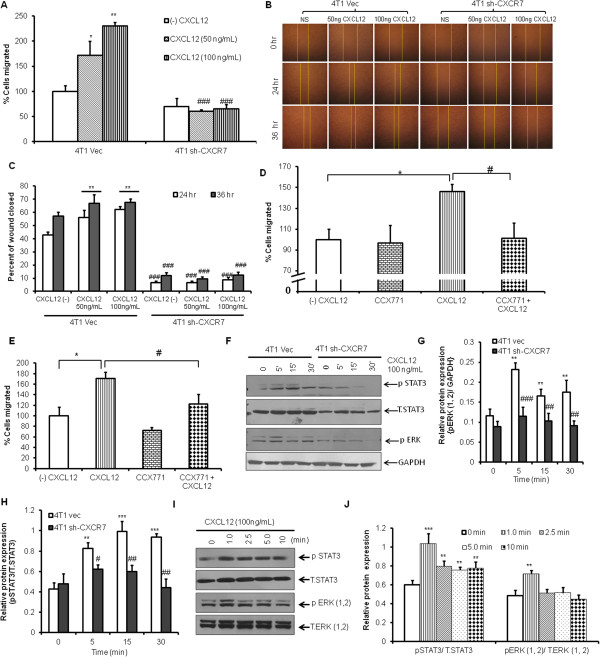
CXCL12 enhances CXCR7-mediated cell migration and signaling. (A) 4T1 Vec and CXCR7 shRNA-transfected cells were subjected to chemotaxis toward CXCL12 (50 and 100 ng/ml) by using the modified Boyden chamber assay, as described in Materials and methods. (B) 4T1 Vec and CXCR7 shRNA-transfected cells were grown to confluence in complete medium in six-well plates, and then a wound was made with a 200-μl pipette tip, and the closure of the wounds was monitored in the presence or absence of CXCL12 (50 and 100 ng/ml) by microscopy after 24 and 36 hours. (C) Quantitative analysis of percentage of wound closure. (D) 4T1 and (E) 4T1.2 cells were pretreated for 1 hour with vehicle or CCX771 (1 μM) and were subjected to chemotactic assay in the absence or presence of CXCL12 (100 ng/ml). (F) 4T1 Vec and 4T1 sh-CXCR7 cells were serum starved for 4 hours and stimulated with CXCL12 (100 ng/ml) for different times, as indicated, and incubated at 37°C. After treatment, cells were washed, lysed, and analyzed with Western blotting for Phospho STAT3, STAT3, Phospho-ERK (p-ERK), and GAPDH by Immunoblotting. (G, H) Densitometry analysis of Western blots shows quantitation of pSTAT3 and pERK levels. (I) 4T1.2 cells were serum starved for 12 hours and stimulated with CXCL12 (100 ng/ml) for different time points, as indicated, and incubated at 37°C. After treatment, cells were washed, lysed, and analyzed for Phospho STAT3, STAT3, Phospho-ERK (p-ERK), and ERK with immunoblotting. (J) Densitometry analysis of Western blots shows quantitation of pSTAT3 and ERK levels, *P < 0.05, **P < 0.01, **P < 0.001 versus none, and ##P < 0.05, ##P < 0.01 ###P < 0.001 versus control.